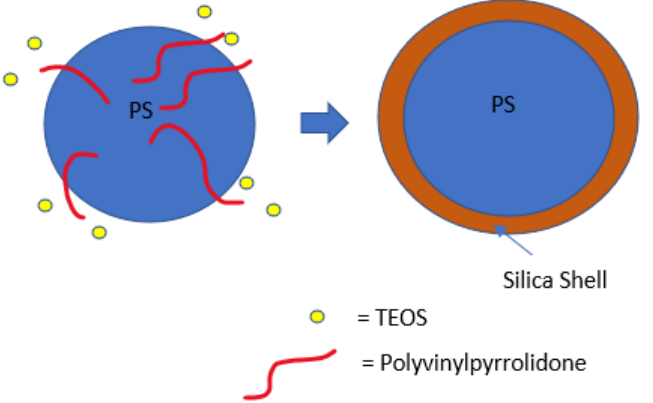
Figure 11. Synthetic route from PS to shell formation on PS due to nucleation of TEOS at PVP. (Adapted from Hong et al.) [92].